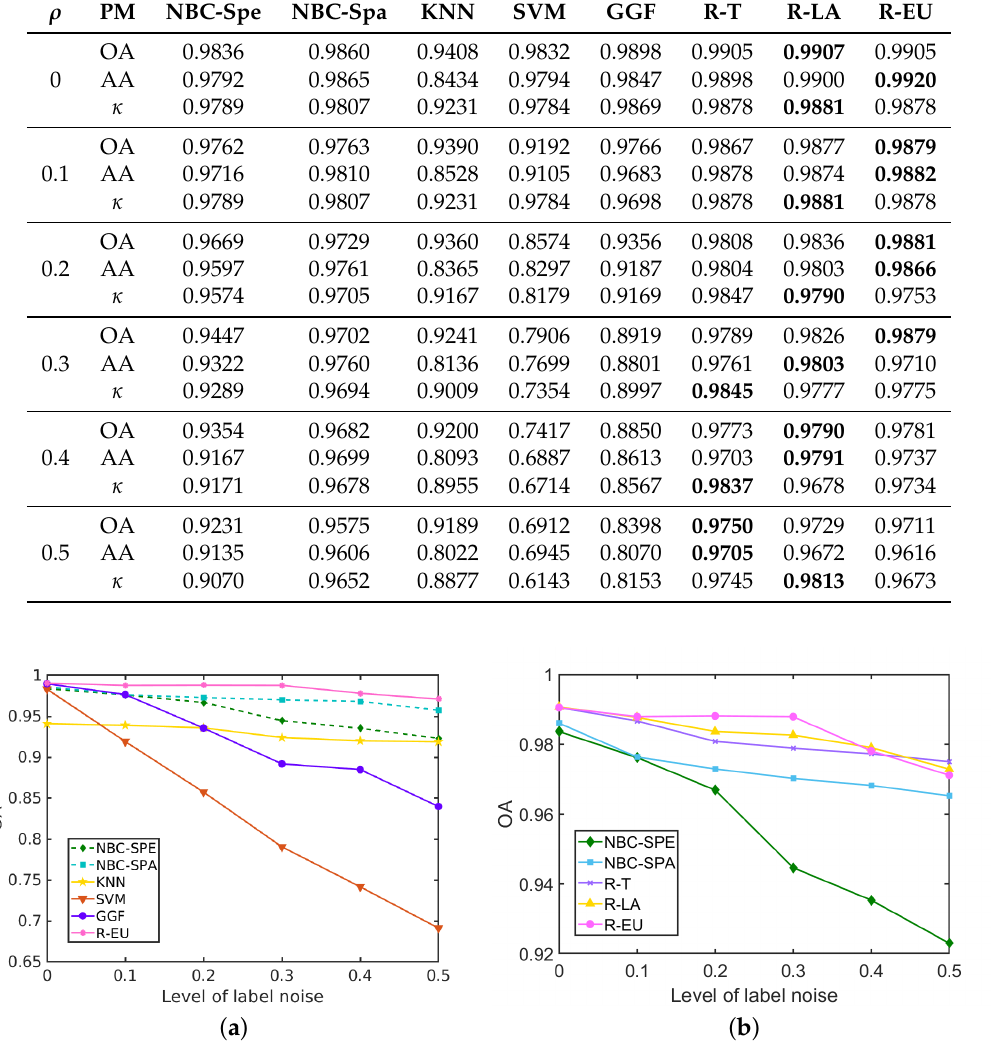
Figure 14. Influence of the label noise on the performance (in terms of OA of different methods) for the Salinas Scene data set. ( a ) R-EU compared with other methods; ( b ) Comparisons among three